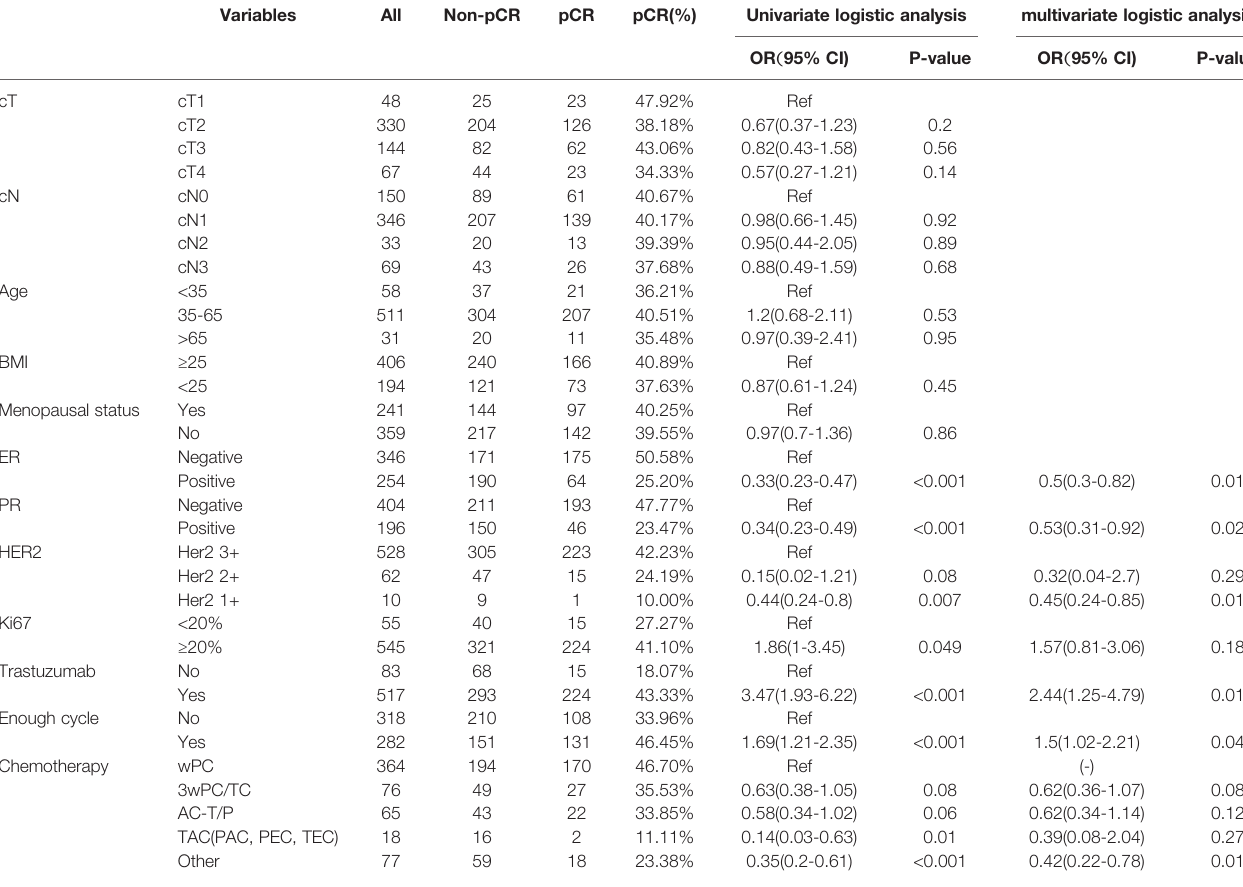
TABLE 1 | Logistic analysis for factors that affect pCR in the training